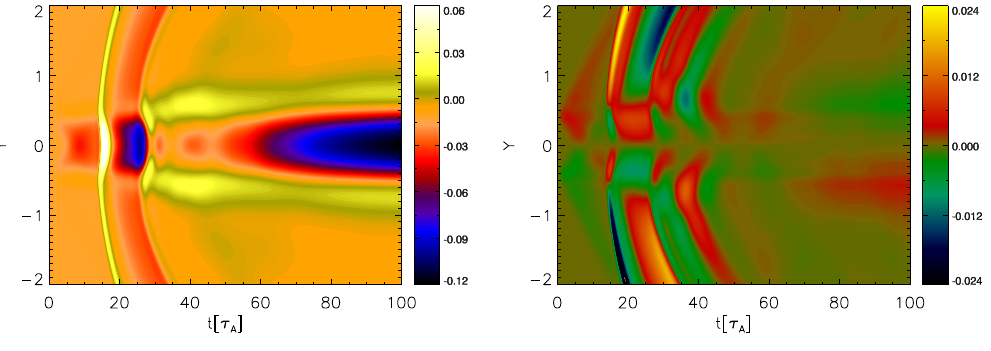
Fig. 3. Time signatures along vertical axis of the loop ( x = y = 0 ) of perturbed mass density (left panel, color scale, units of % 0 ) and y component of velocity (right panel, color scale, units of V A0 ) in case of excitation with the pulse (A) shown in top panel of Fig. 2. The loop is centered around y = 0 . Spatial coordinates are given in units of L s .